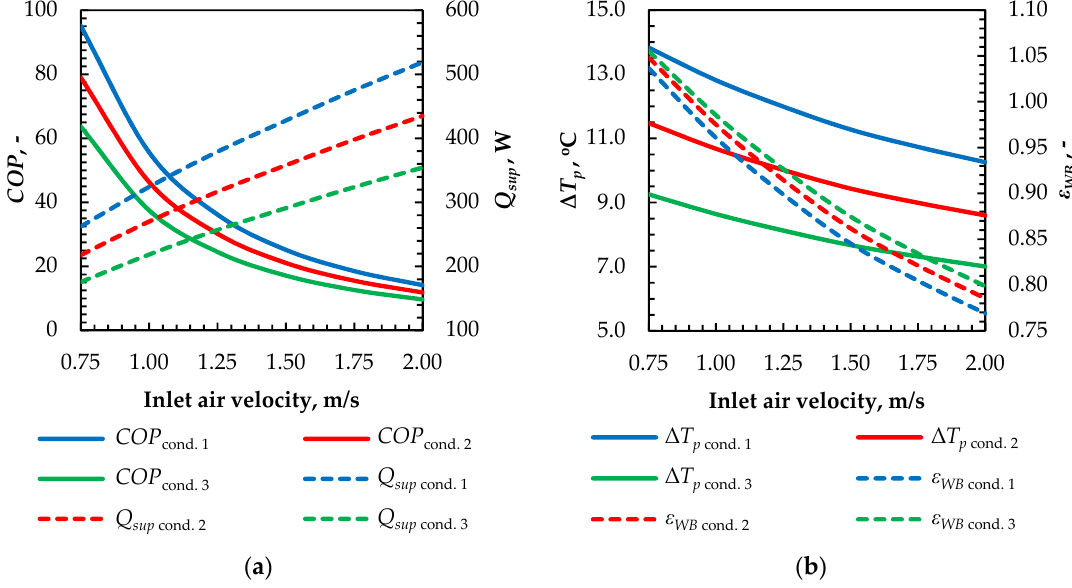
Figure 9. Impact of inlet air velocity: ( a ) COP coefficient and supply cooling capacity; ( b ) Product air temperature difference and wet bulb effectiveness.